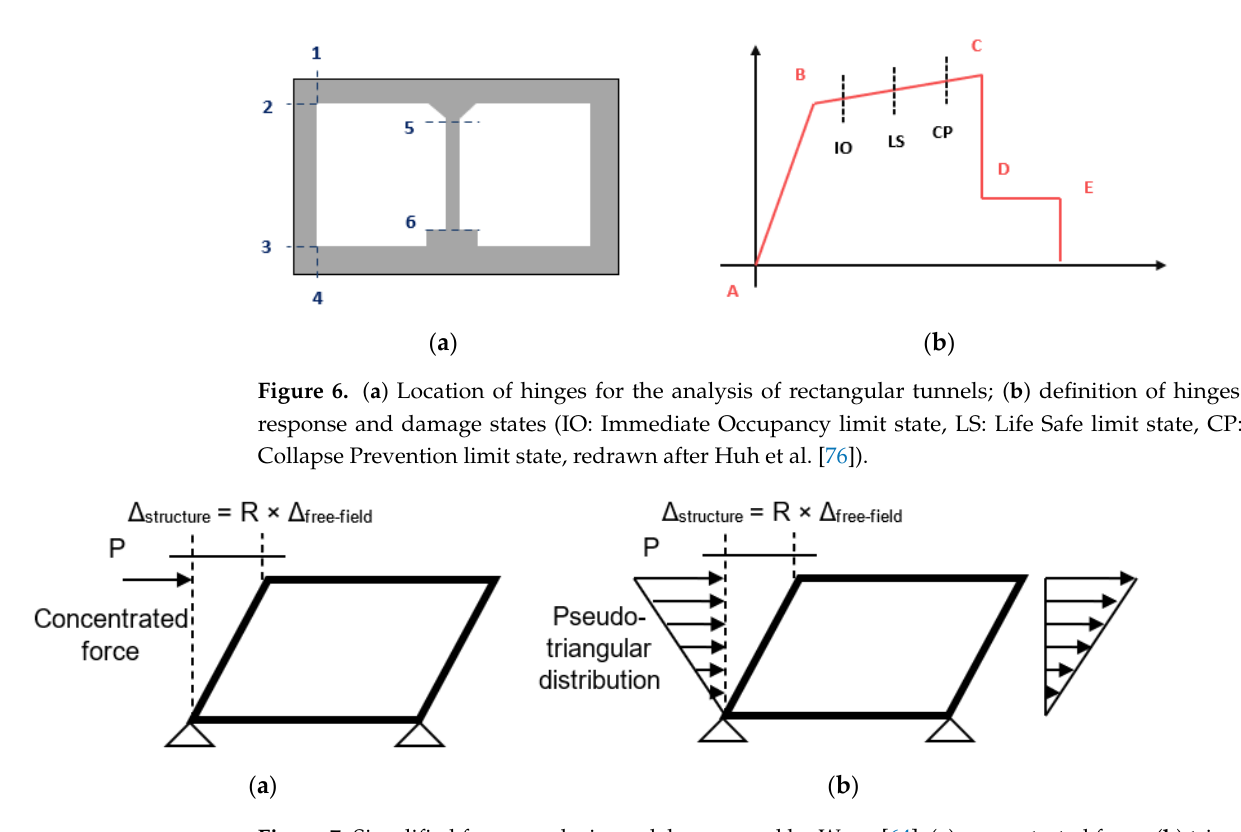
Figure 7. Simplified frame analysis models proposed by Wang [64], ( a ) concentrated force, ( b ) triangular distribution (redrawn after Huo et al. [76]).